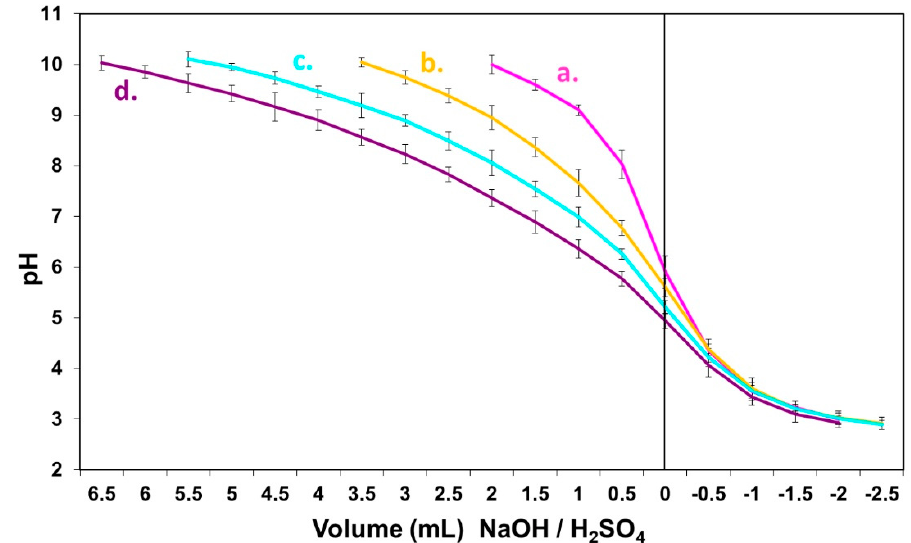
Figure 2. Buffer capacity effect of an oak/pine mixture furnish on the pH variation with: ( a ) 0% oak furnish-control; ( b ) 10% oak furnish; ( c ) 20% oak furnish; ( d ) 30% oak furnish.